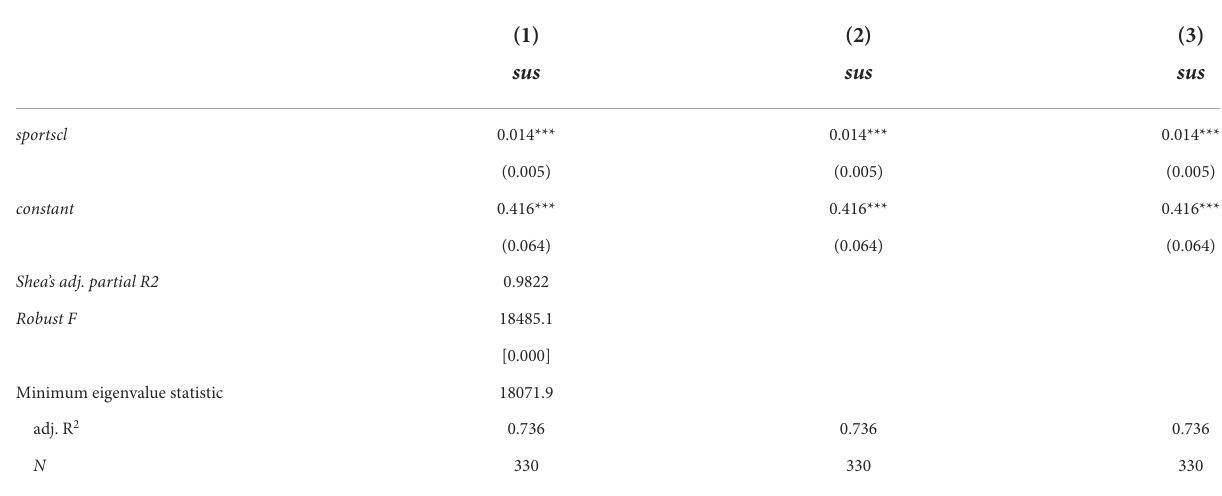
TABLE 5 Endogeneity